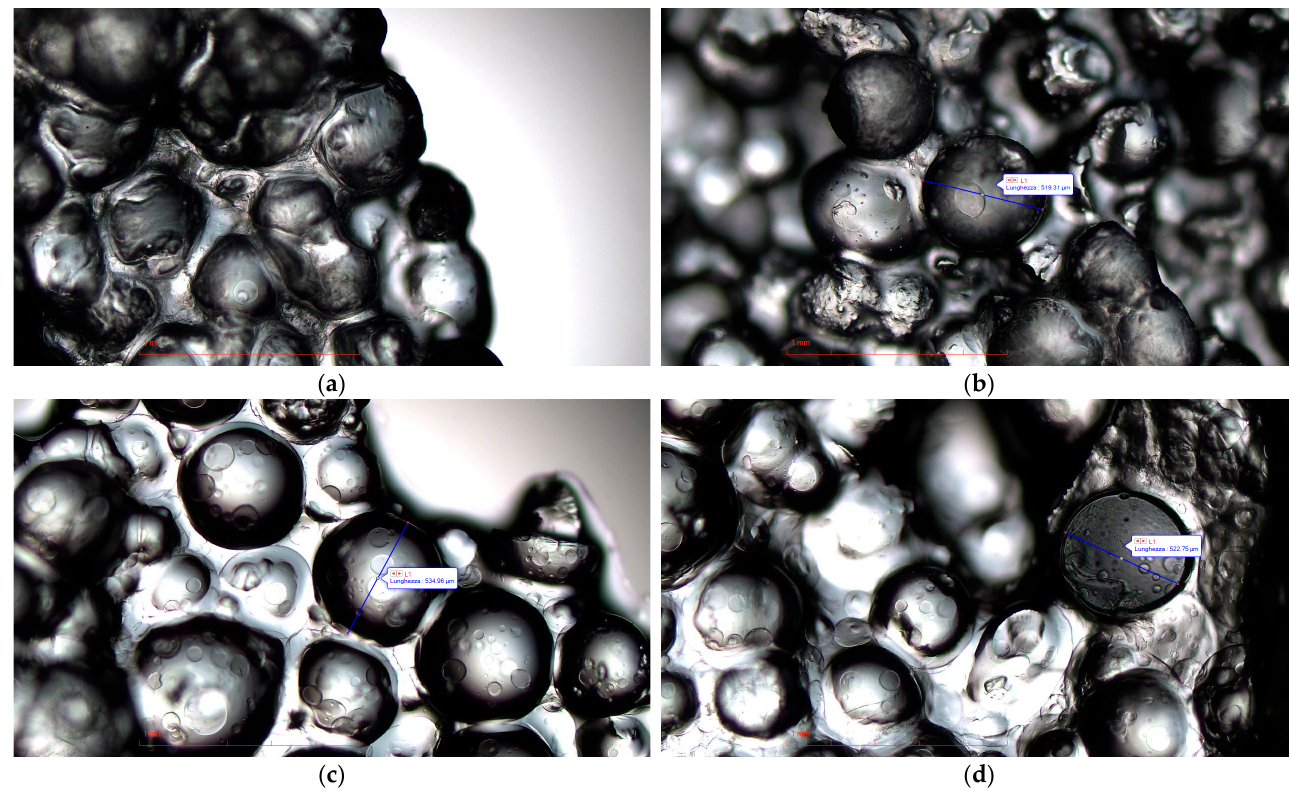
Figure 3. Optical microphotographs (using a 4× objective) of R1HG ( a , b ) and R2HG ( c , d ), at their EDS.